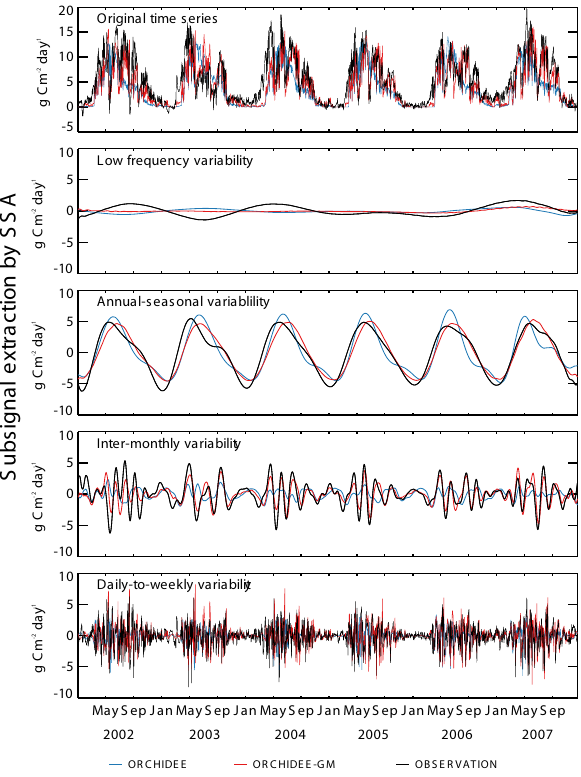
Fig. 6. Model–data comparison on multiple timescales. Observed and modeled time series are decomposed into subsignals corre- sponding to characteristic frequency bins. Qualitative or quantita- tive model–data comparisons can be carried out on the correspond- ing pairs of subsignals. Figure 6 exemplifies the model–data com- parison with two models simulations of GPP and corresponding ob- servations at the